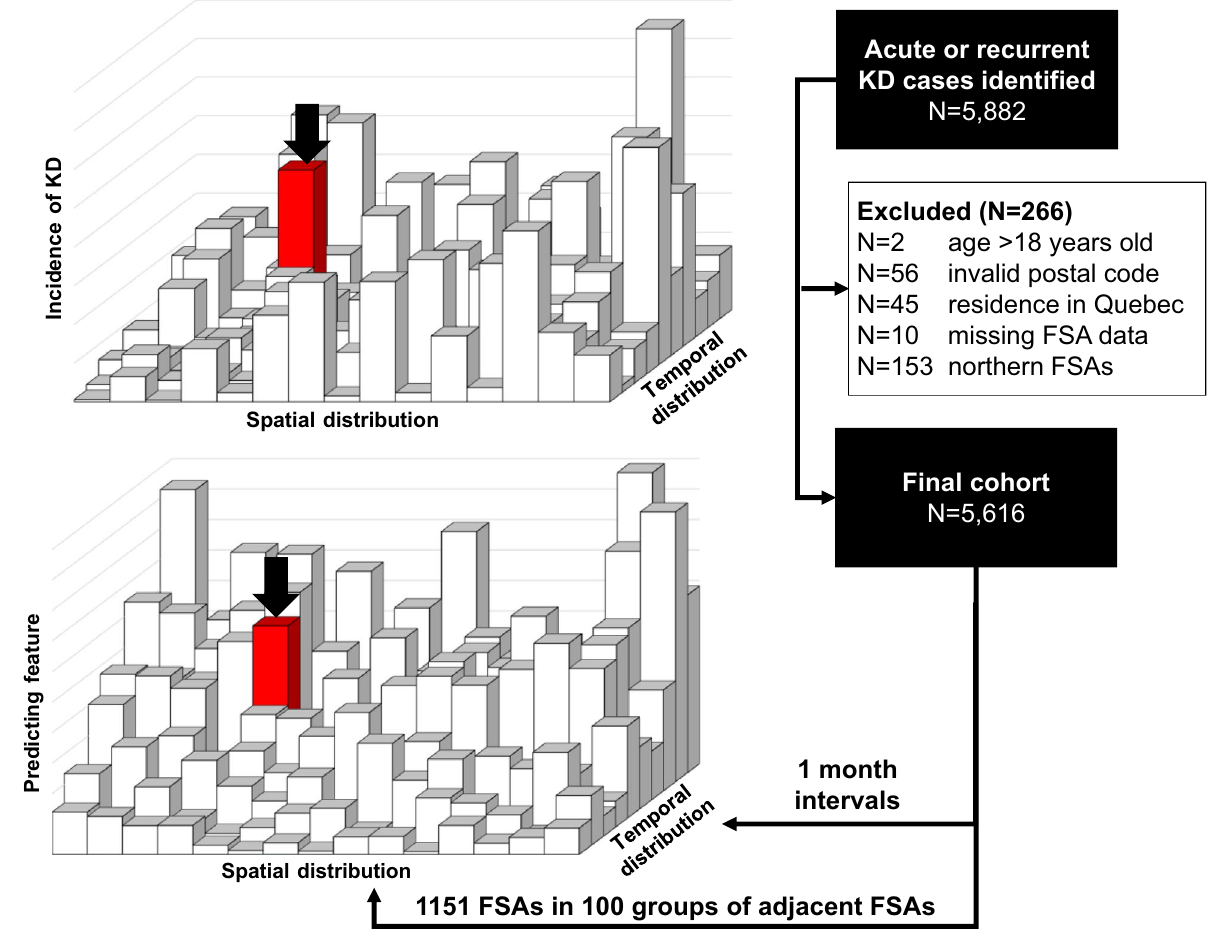
Figure 1. Identification of KD patients and theoretical framework of the spatiotemporal matrix for use for modelling. The spatial and temporal scales were held constant for incidence of KD and the distribution of all predictive features so that data points at the same position in the matrix are aligned with each other in time and space. The temporal (1 month) and spatial (group of ~ 10 FSAs) calipers were decided based on density distribution of the incidence of KD. The example below (red bar) shows the alignment of the incidence of KD and of a generic predicting feature at a specific time and location in our spatiotemporal matrix. KD Kawasaki disease, n number, FSA Forward Sortation